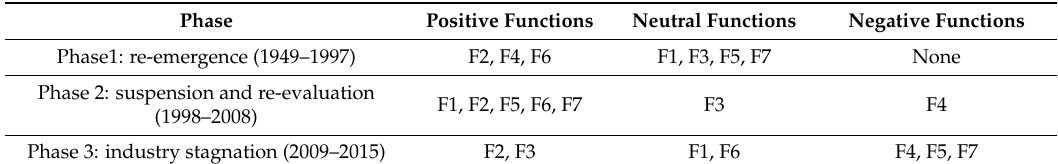
Table 4. The influence of policies in system functions.